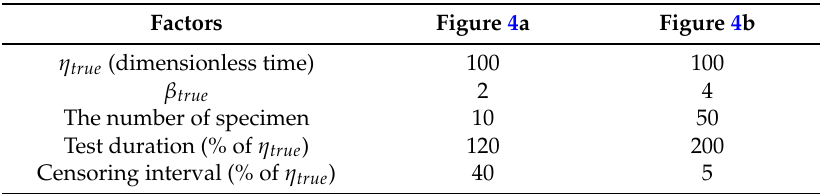
Table 3. Combinations of experimental factors applied to examples in Figure 4. Factors Figure 4a Figure 4b η true (dimensionless time) 100 100 β true 2 4 The number of specimen 10 50 Test duration (% of η true ) 120 200 Censoring interval (% of η true ) 40